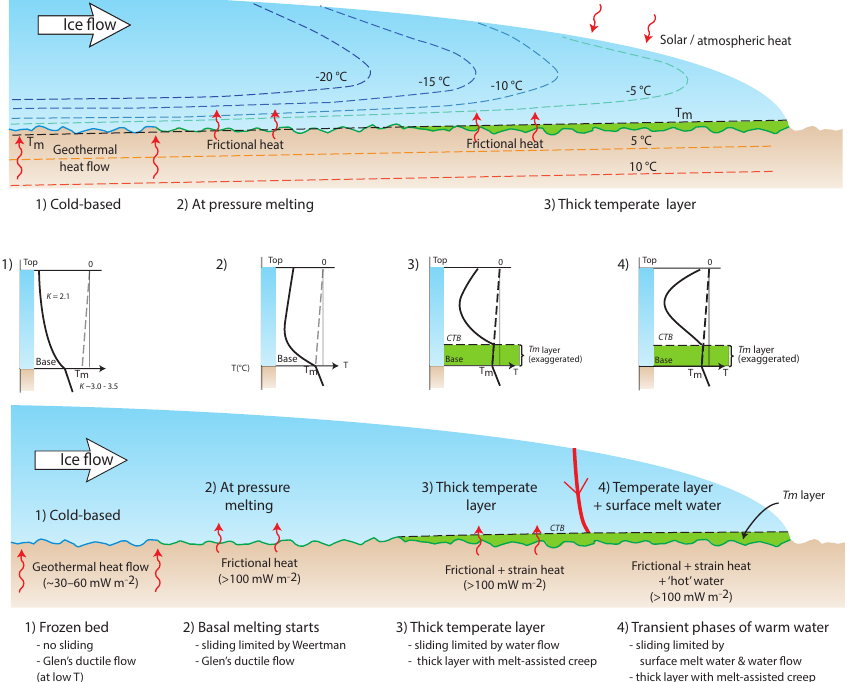
Figure 7. Hypothetical half ice sheet (e.g. Dahl-Jensen, 1989), with different thermal regimes, further explained in the text. CTB is the cold-temperate boundary; K is thermal conductivity, in Wm − 1 K − 1 ; T m is melting temperature. Numbers correspond to different thermal regimes described in